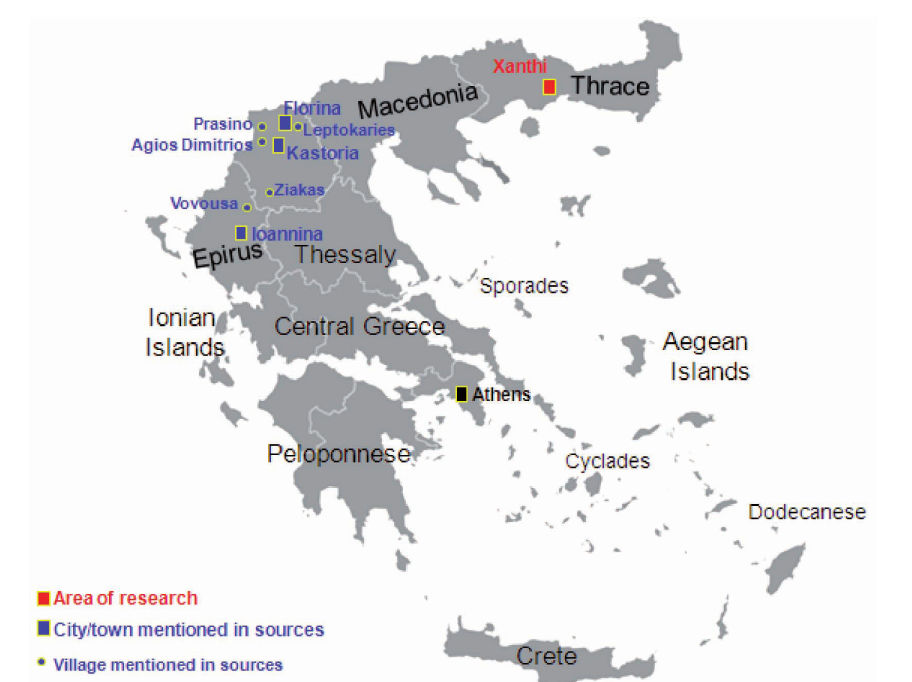
Figure 1: Map of Greece showing cities, towns and villages mentioned in the sources used in the tests and related to the removal of children during the Greek Civil War (see Appendices 1 and